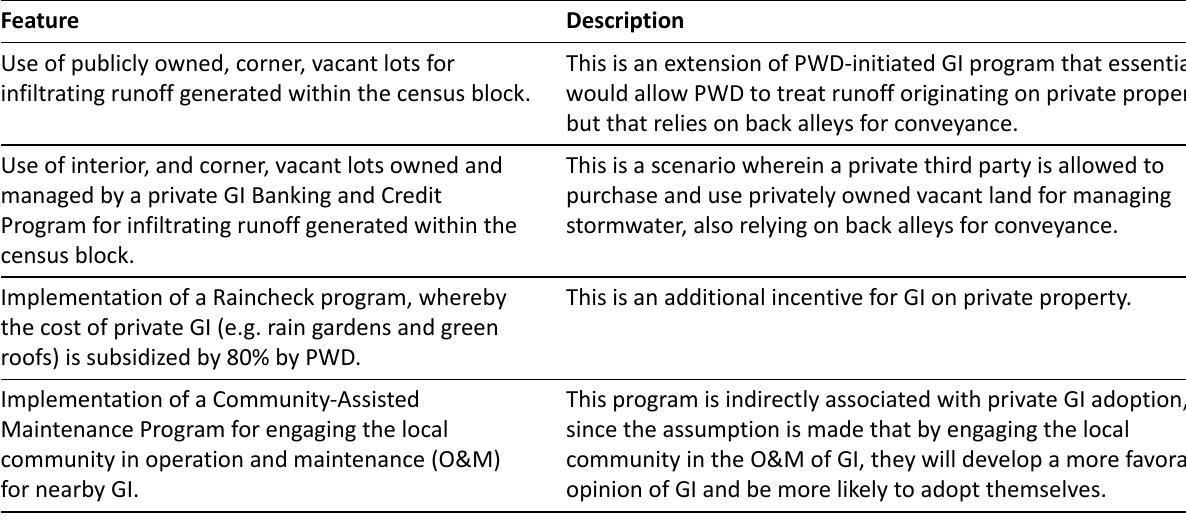
Table 1. Features alternatively toggled “on” of “off” in the model runs.